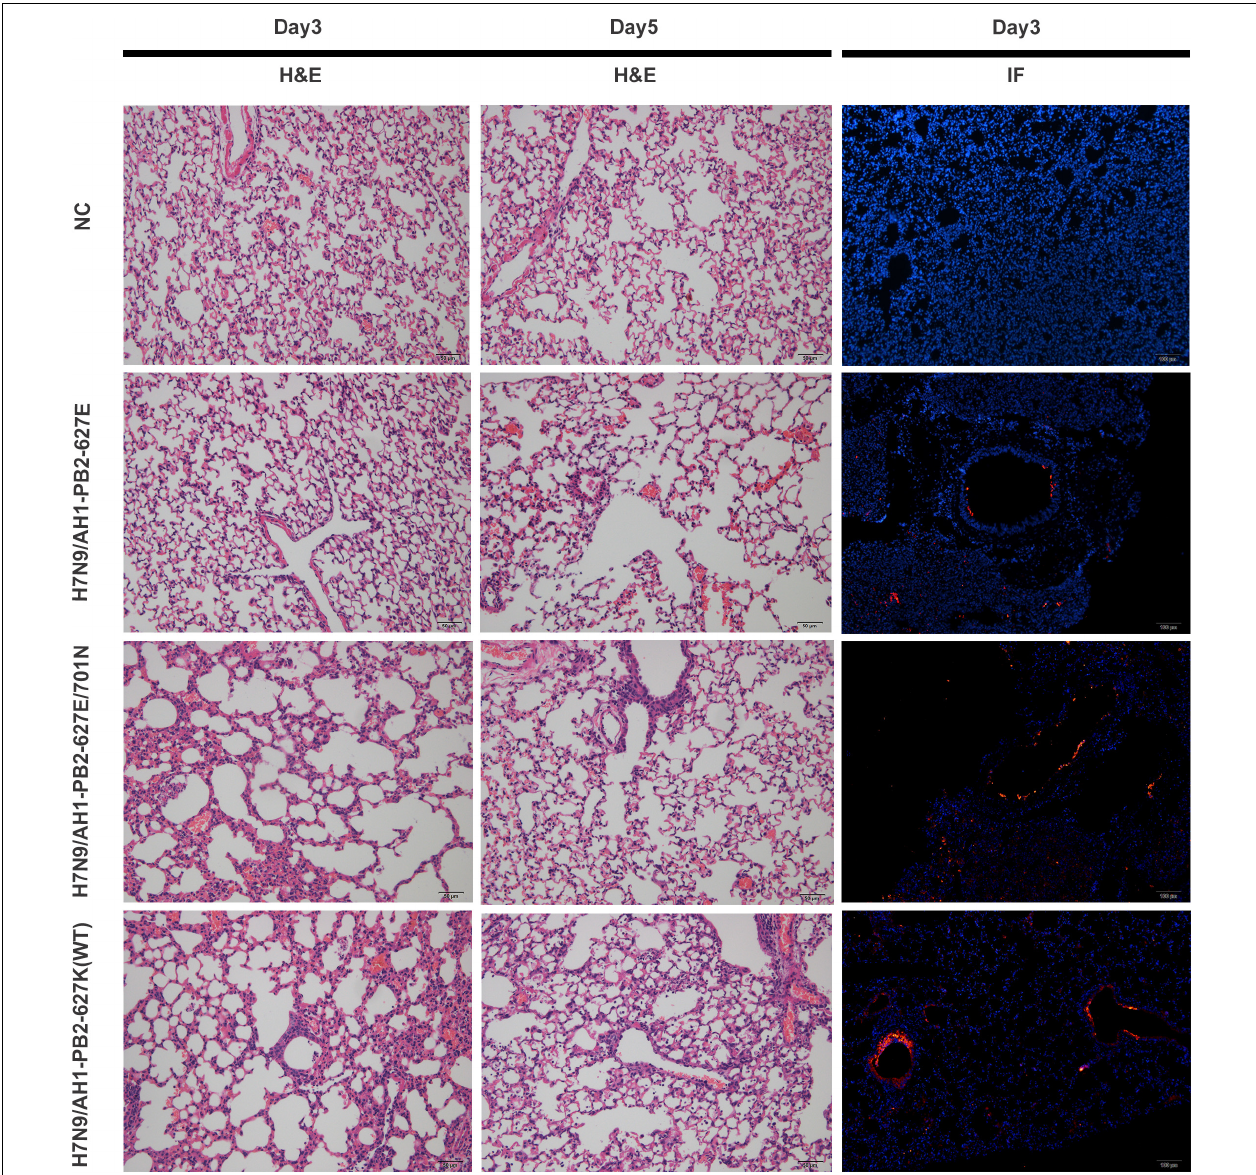
FIGURE 1 | Pathological analysis of lung tissues of mice infected with H7N9/AH1-PB2-627K(WT) and its mutant viruses on day 3 or 5 post-infection. Scale bars: HE (50 µ m); IF (100 µ m).